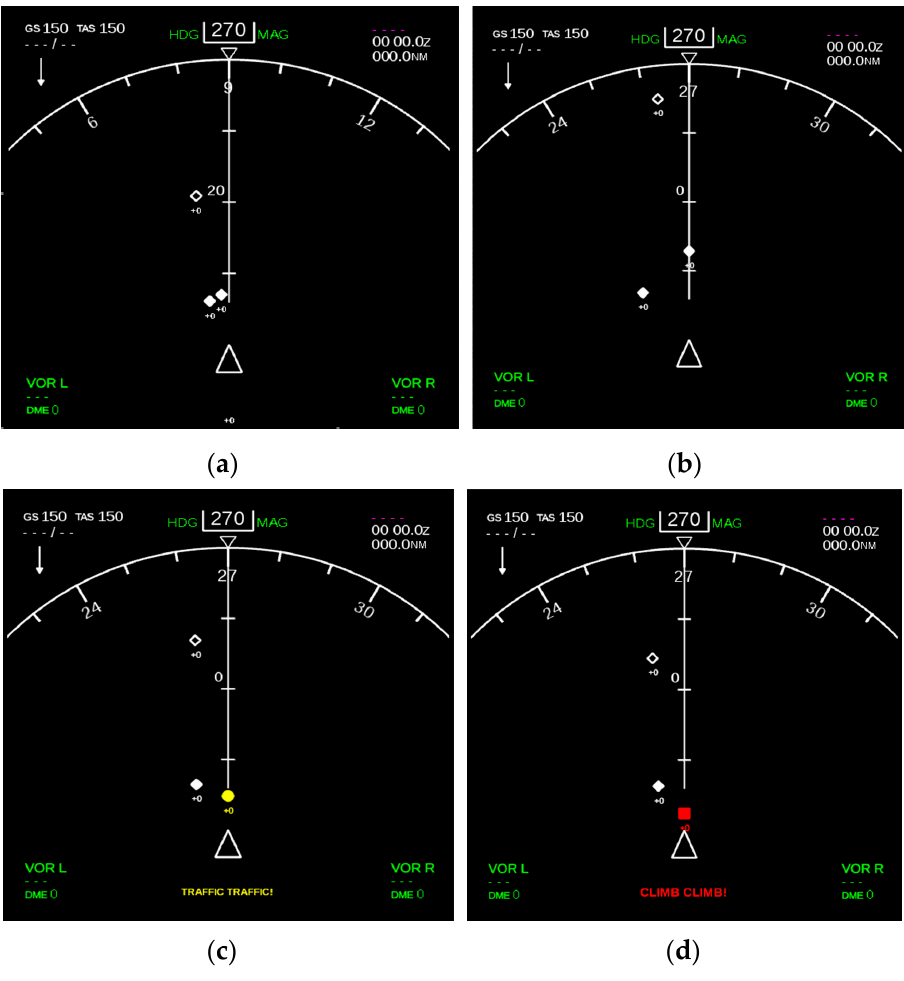
Figure 17. TCAS Digital Mock-Up. ( a ) Nothreat; ( b ) Proximate; ( c ) TA; ( d ) RA.